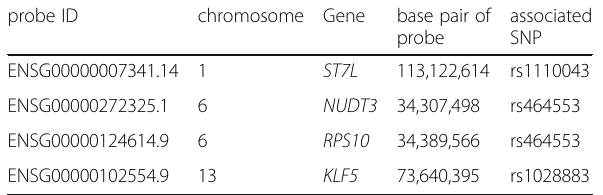
Table 6 SMR of GTEx eQTLs and appendicular lean mass GWAS, results for skeletal muscle